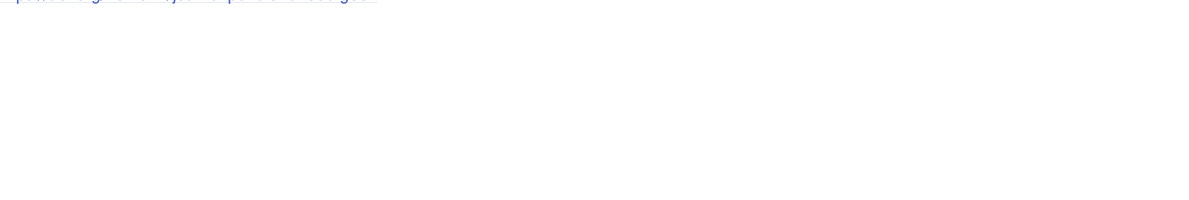
PLOS ONE | https://doi.org/10.1371/journal.pone.0261658 December31, 2021 11 /